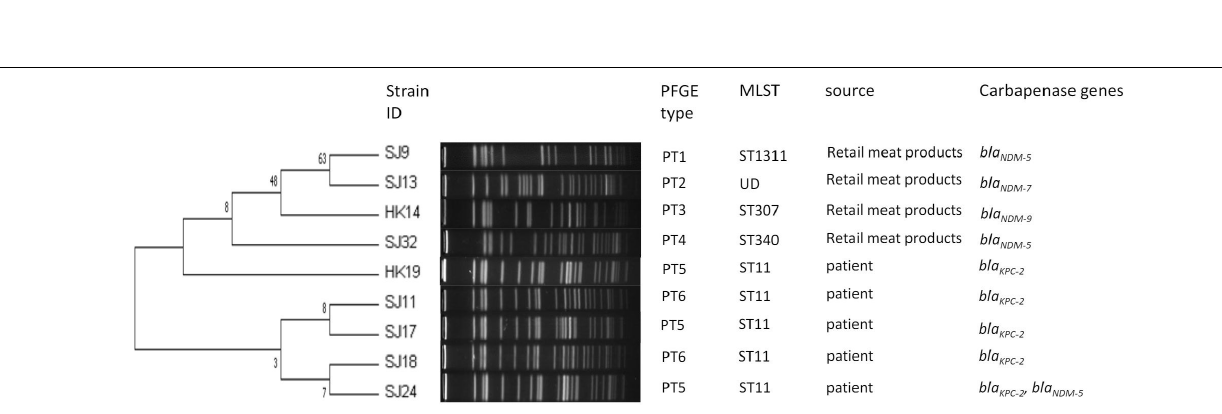
Frontiers in Microbiology |